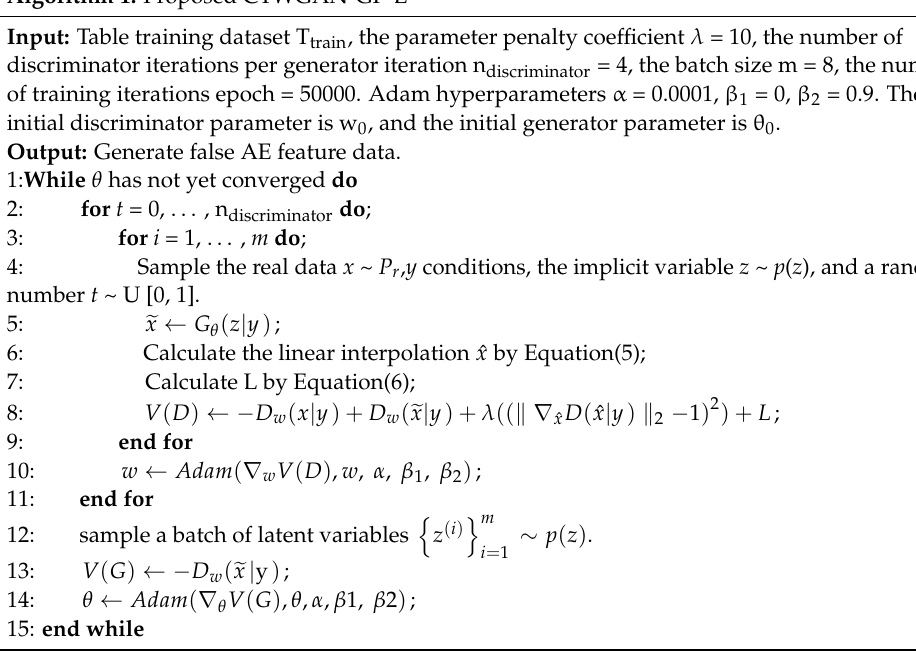
Algorithm 1: Proposed CTWGAN-GP-L